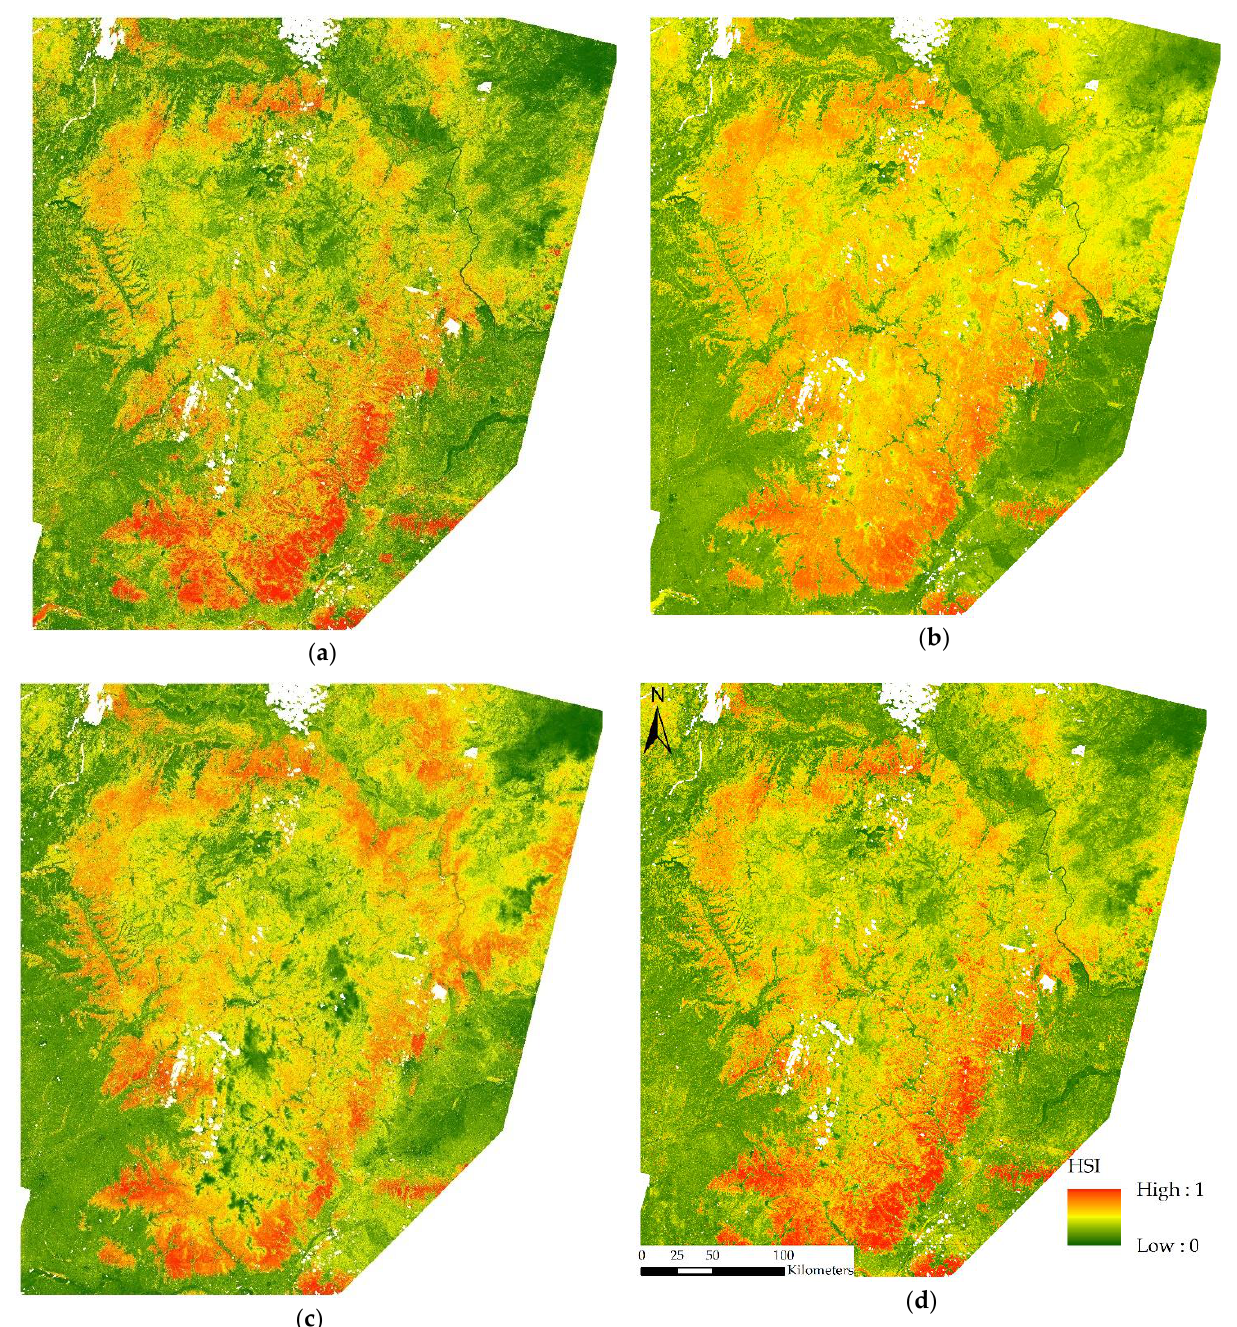
Figure 5. Habitat suitability index (HSI) for 3 species of ungulates according to linear discriminant analysis (LDA): ( a ) wild boar, ( b ) roe deer, ( c ) red deer, and ( d ) integrated suitability index.